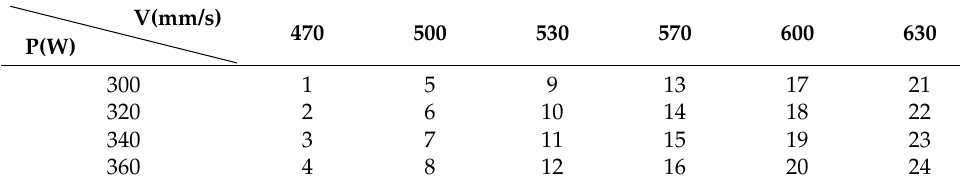
Table 6. Parameters of the second orthogonal